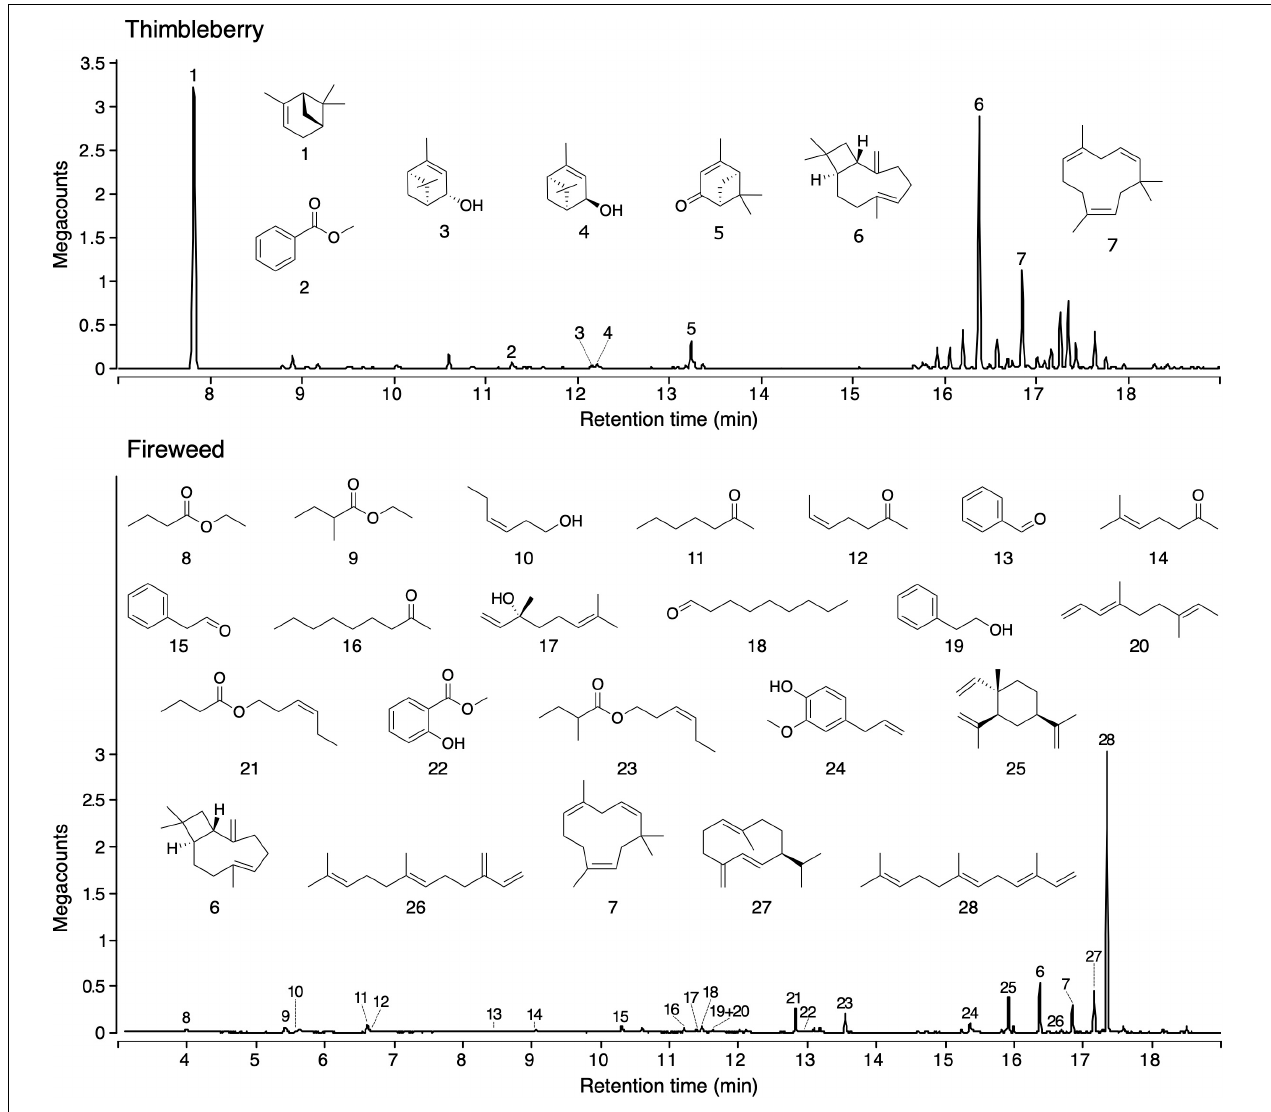
FIGURE 3 | Total ion chromatograms of headspace volatile extracts (HVEs) of thimbleberry (Top) and fireweed (Bottom) . Headspace volatiles were adsorbed on Porapak Q ( Figure 1 ) and desorbed with pentane/ether (1/1). HVEs were analyzed by gas chromatography-mass spectrometry (GC-MS; Agilent 7890B GC coupled to a 5977A Series MSD). Names of compounds are listed in Table 2